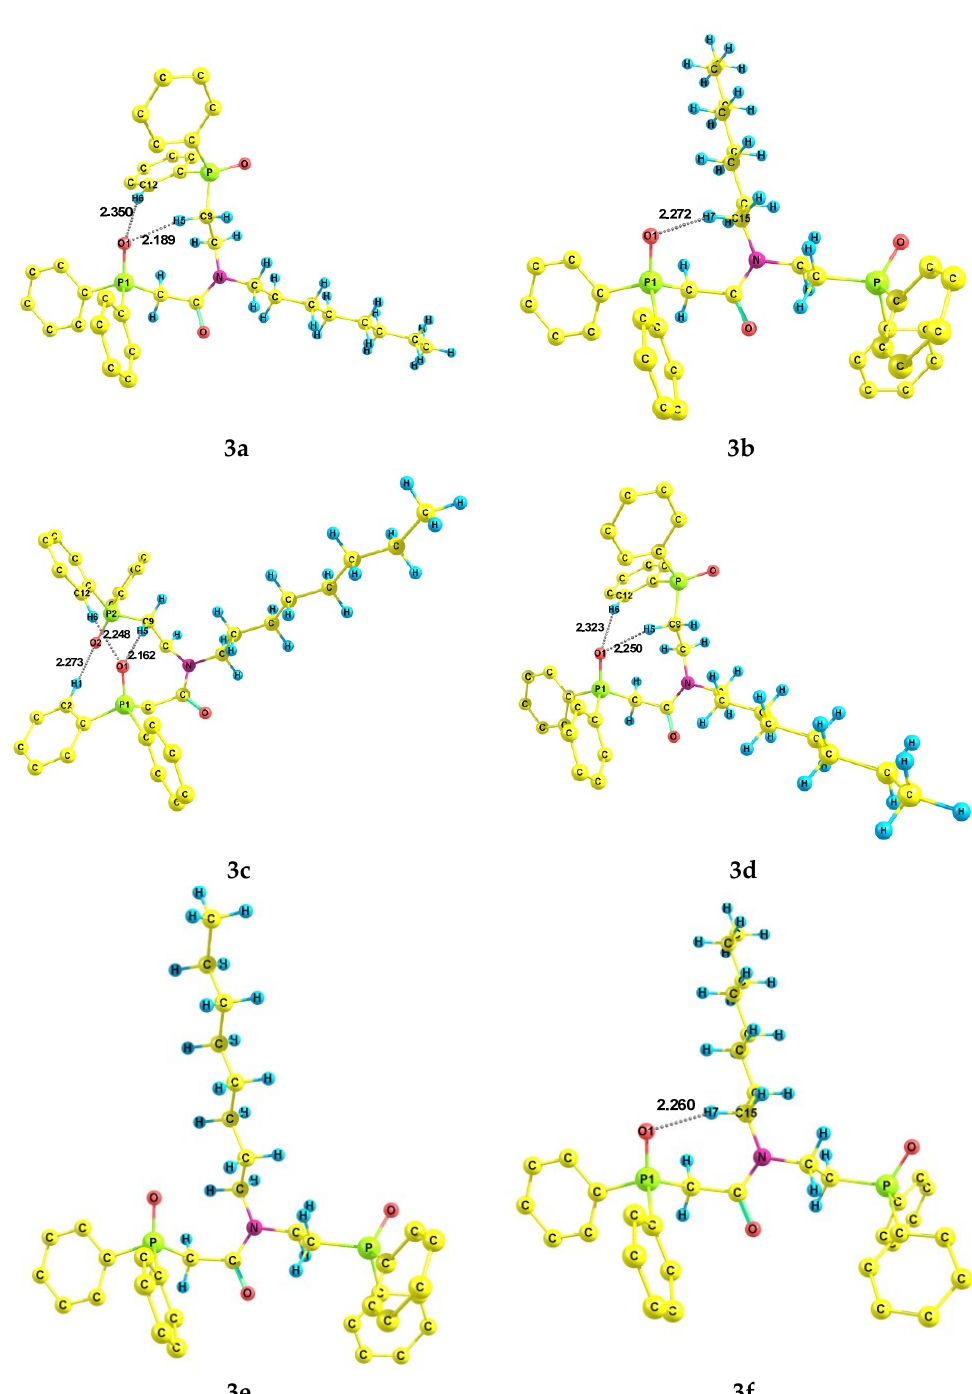
Figure 3. Preferred conformers of 3 according to DFT calculations (some hydrogen atoms are omitted). Distances are given